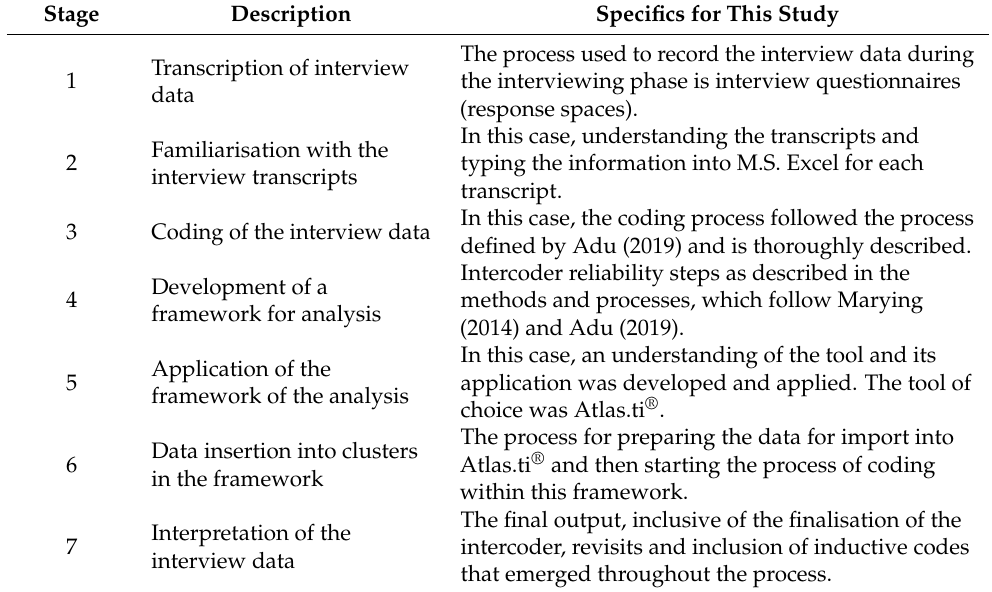
Table 3. Intercoder framework